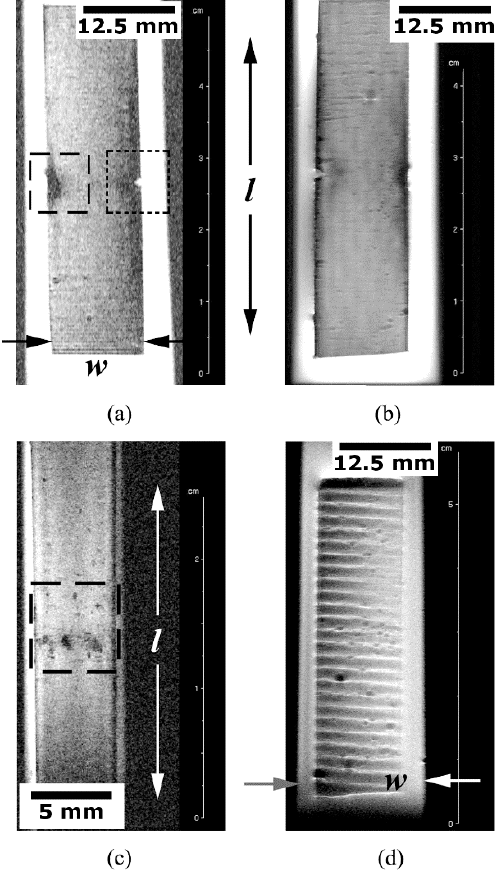
Figure 7. Surface analysis of the translaminarly fractured PPS-CF test coupon: ( a ) C-view with focus set in surface damage and geometrical discontinuity; ( b ) C-view with focus set in surface texture quality; ( c ) S-view of surface crush damage; and ( d ) C-view of the defective EPX-GF surface.